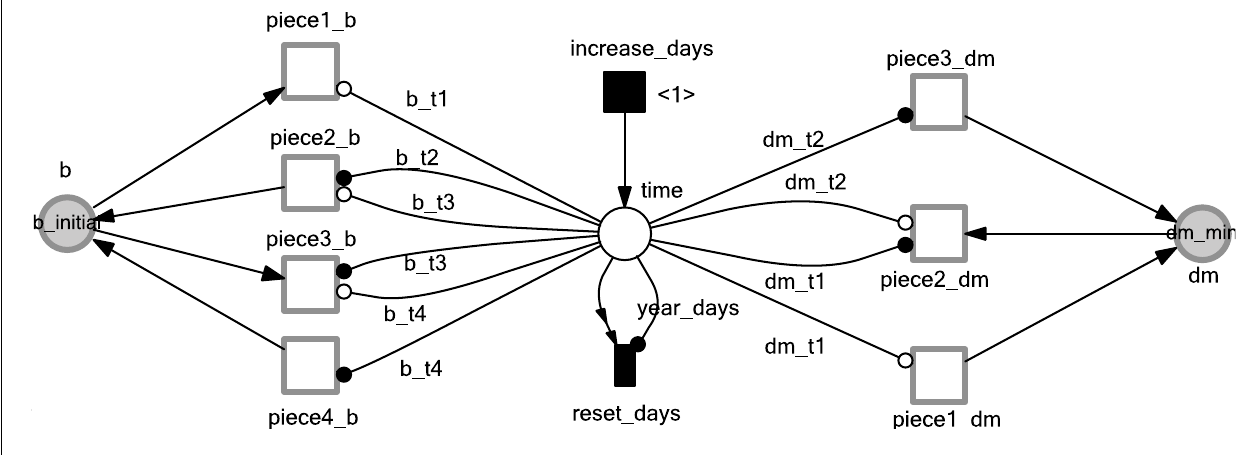
FIGURE 6 | GHPN submodel to reproduce the seasonal variability on mortality and biting rates. The deterministically time delayed transition, increase _ days , fires at each time step increasing the current simulation time by one day. The immediate transition reset _ days resets the current time to